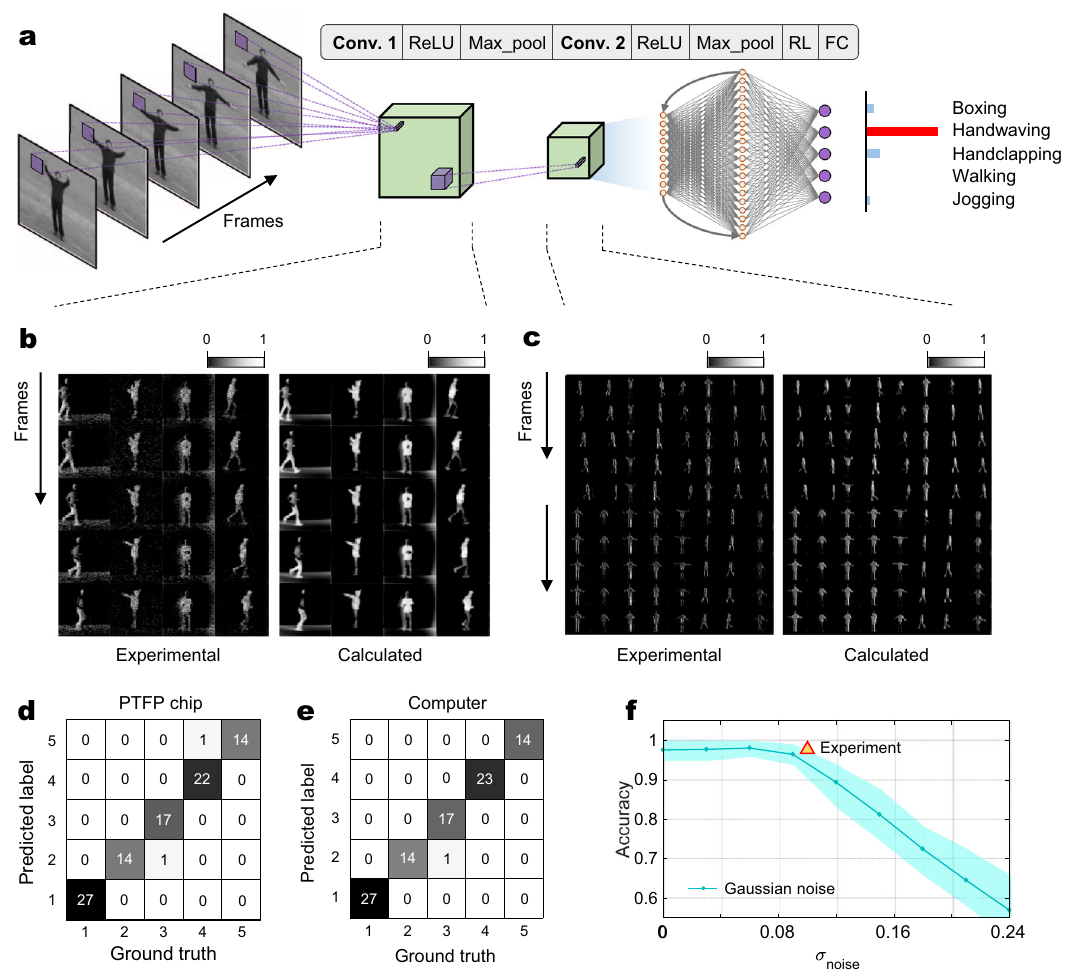
Fig. 4 | Experimental results of video action recognition of the KTH dataset. a The adopted neural network model. Input data is a segment of video with fi ve frames.Theneuralnetworkcomprisestwoconvolutionallayerswithactivationand poolinglayers,arecurrentlayer(RL),andafullyconnectedlayer(FC).The ‘ Conv.1 ’ and ‘ Conv.2 ’ layersarecomputedbythePTFPchip. b and c Convolutionalresultsof the PTFP chip of Conv. 1 and Conv. 2, respectively. Subplots from top to bottom display the convolved images of different frames. From left to right, several